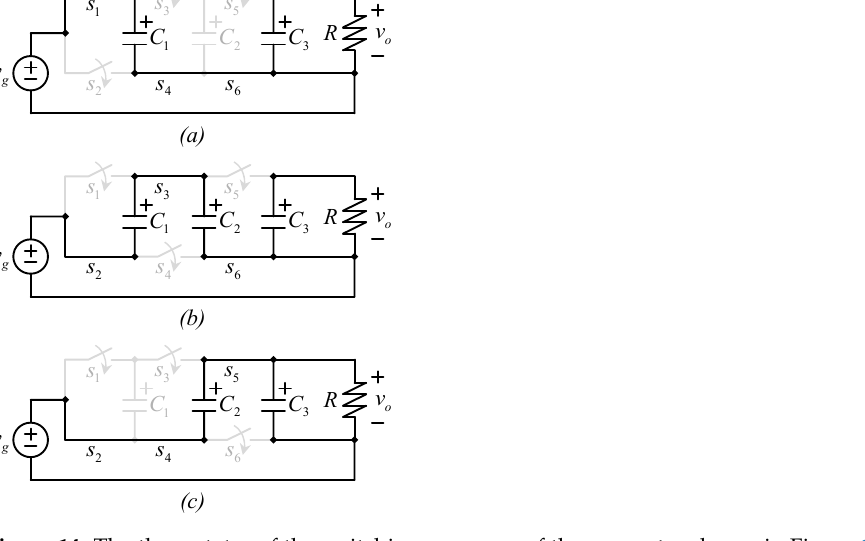
Figure 14. The three states of the switching sequence of the converter shown in Figure 13, ( a ) first switching state, ( b ) second switching state, and ( c ) third switching state.